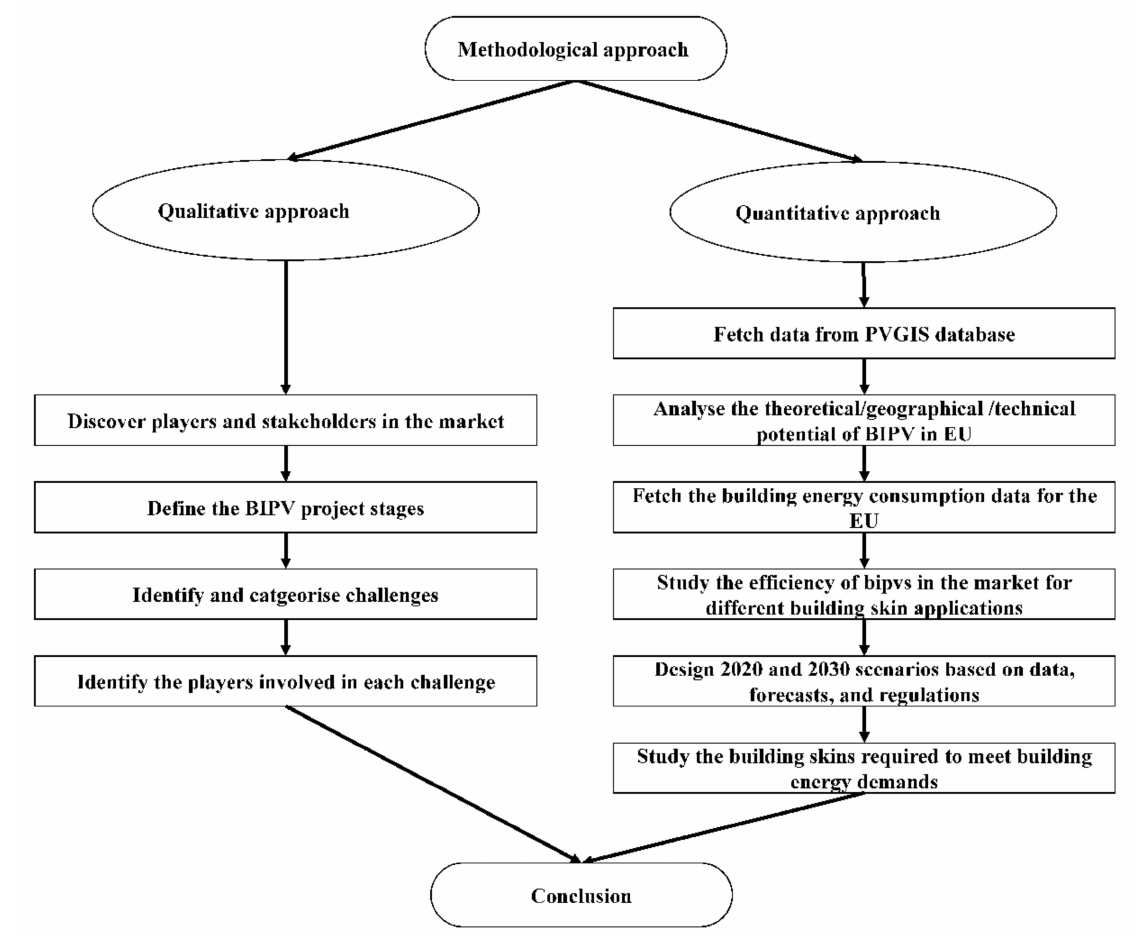
Figure 1. Flowchart of the